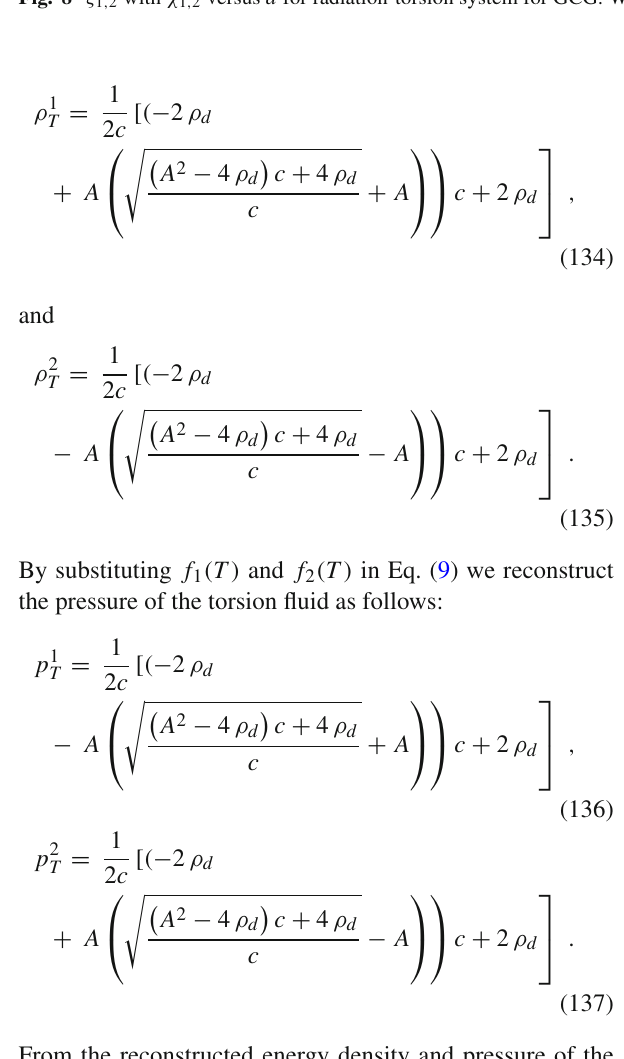
Fig. 8 ξ 1 , 2 with χ 1 , 2 versus a for radiation-torsion system for GCG. We use c = 3 and A = 0 . 8 for all numerical plotting